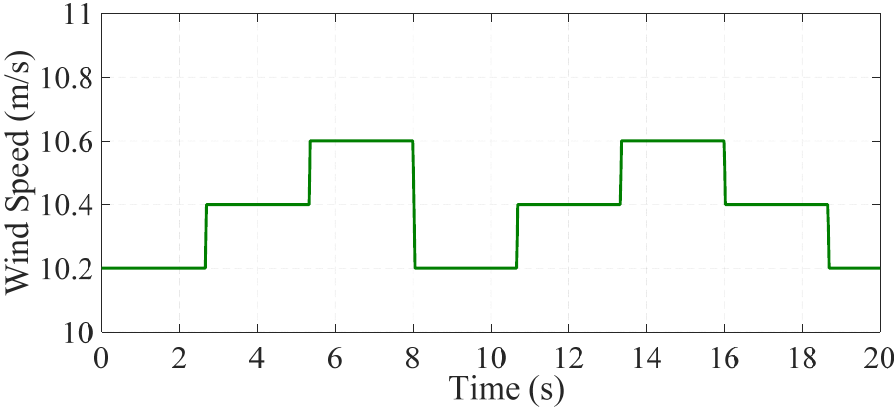
Figure 12. Wind speed scenario applied to the PMSG system.